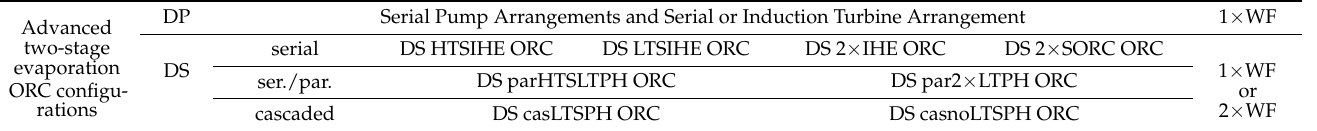
Table 1. Categorization of advanced two-stage evaporation ORC configurations (wf, working